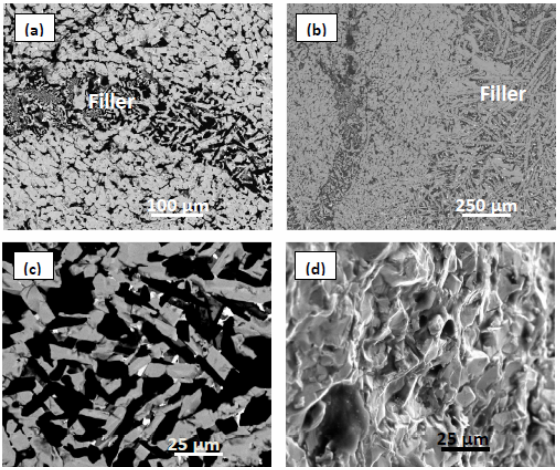
Fig. 9 (a) and (b) BSE images of cross section of welded PLRS 2.0 composite. (c) Filler area at higher magnification: dark phase SiC, grey phase ZrB 2 , and bright phase tungsten. (d) SEM image of fracture surface after shear testing of the welded